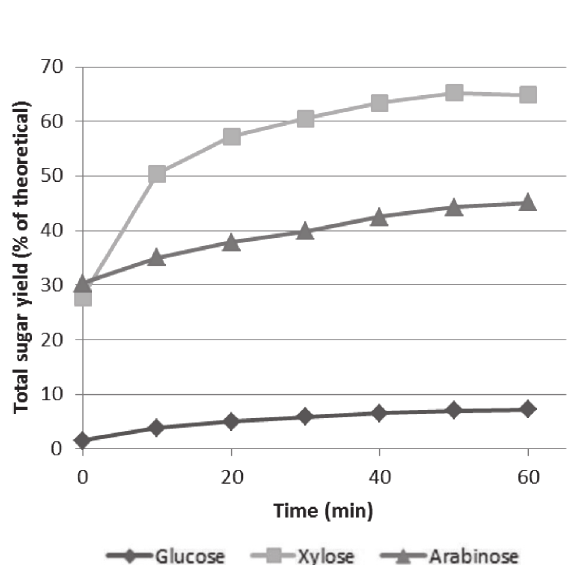
Fig. 4 – Hydrolysis with 1.5 % (w/w) sulfuric acid, at 120 °C and with 7 % (w/w) dry matter on arabinose reduced corn stover on a pilot scale. Arabinose removal was performed with 0.3 % (w/w) sulfuric acid, at 90 °C, 4-hour reaction time and with 10 % (w/w) dry